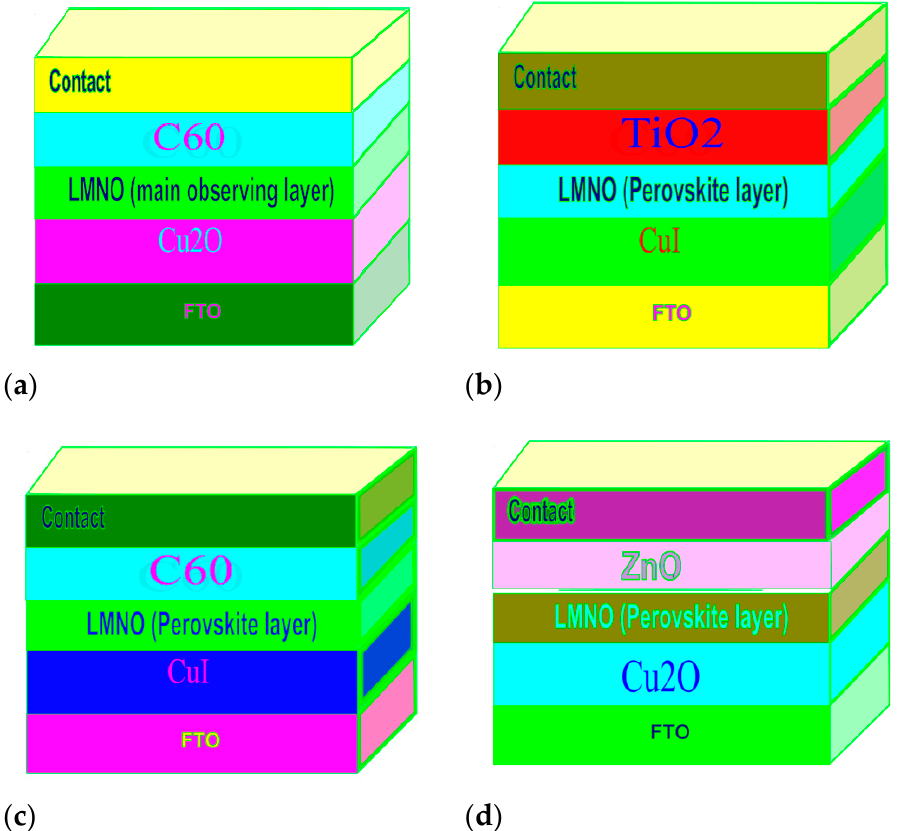
Figure 3. Schematic of various structures. ( a ) Structure1—C 60 /LMNO/Cu 2 O, ( b ) Structure2—TiO 2 /LMNO/CuI, ( c ) Structure3—C 60 /LMNO/CuI, ( d ) Structure4—ZnO/LMNO/Cu 2 O. The parameters of different materials are shown in Table 1. These parameters were used during simulation in SCAPS